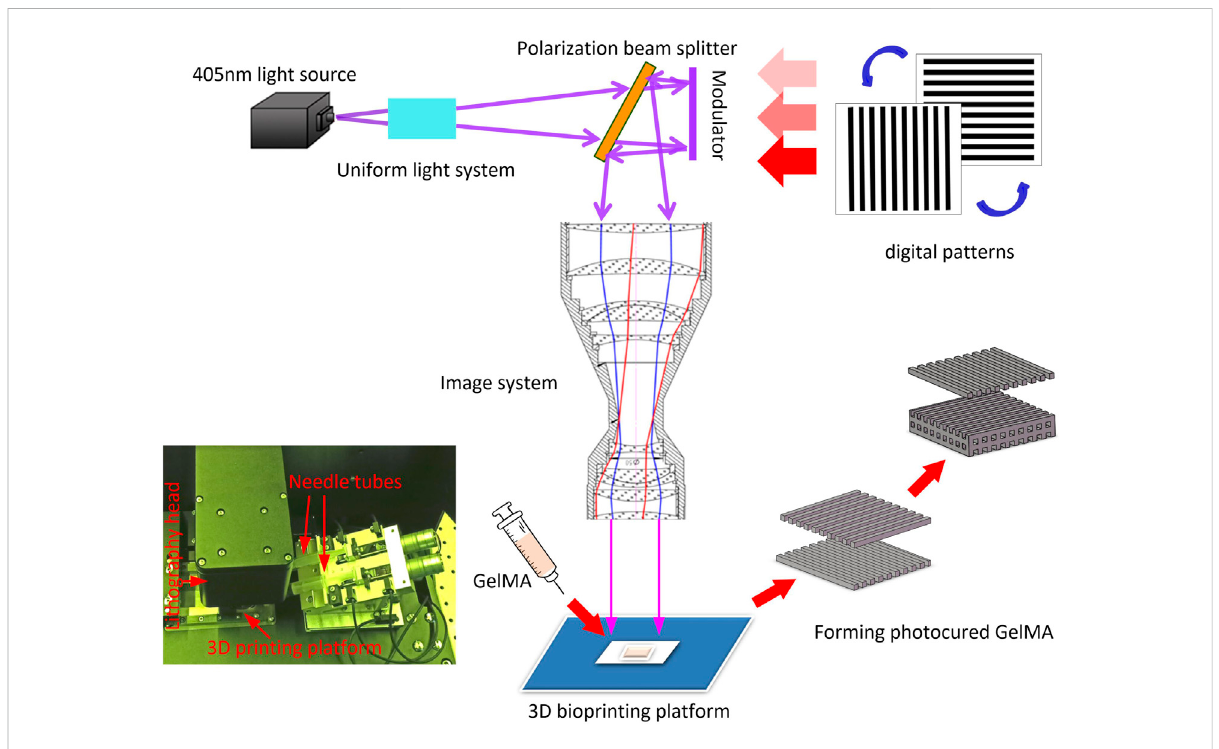
FIGURE 2 Schematic of 3D printer and printing